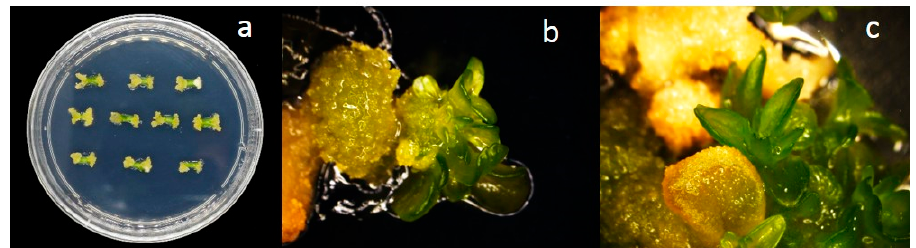
Figure 2. Panels showing different morphogenesis in carnation cv. ‘Jinju’ depending on the type of leaves used. ( a ) Callus induction from normal leaves (derived from Type 1 medium), ( b ) shoot regeneration from vitrified leaves (derived from Type 2 medium), and ( c ) shoot regeneration from vitrified leaves (derived from Type 3 medium).